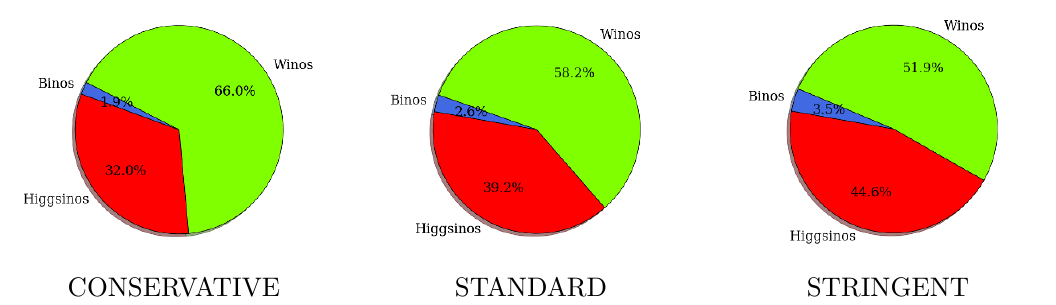
Figure 23 . Fractions of neutralino 1 types in our scan after imposing all the constraints (including only the upper bound for the relic density).